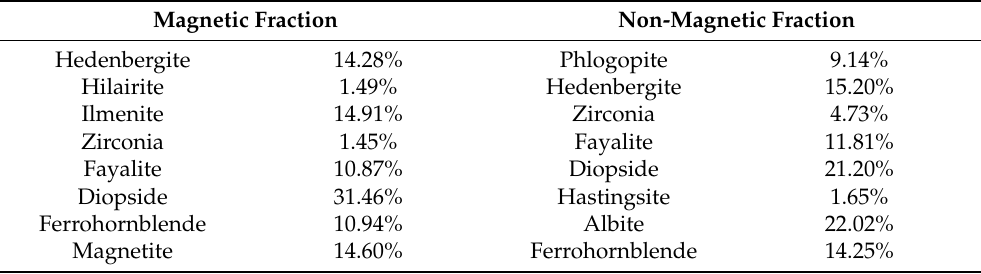
Table 4. Mineral phases of the magnetic and non-magnetic fraction of the silicate-based ore. Magnetic